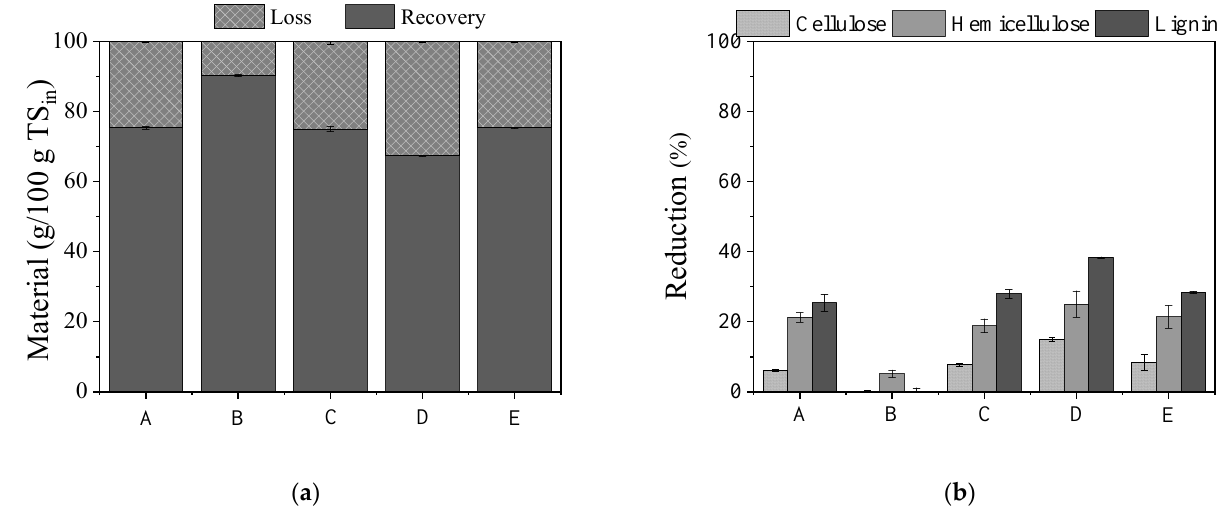
Figure 1. ( a ) Material loss and recovery expressed as g/100g TS in (in: initial biomass); ( b ) reduction of lignocellulosic content during different pretreatment approaches. (A) NaOH (0.5% w / v ), (B) H 2 O 2 (0.5% v / v ), (C) mixture of NaOH (0.5% w / v ) and H 2 O 2 (0.5% v / v ) at ratio 1:1, (D) initially NaOH (0.5% w / v ) followed by H 2 O 2 (0.5% v / v ), and (E) initially H 2 O 2 (0.5% v / v ) followed by NaOH (0.5% w / v